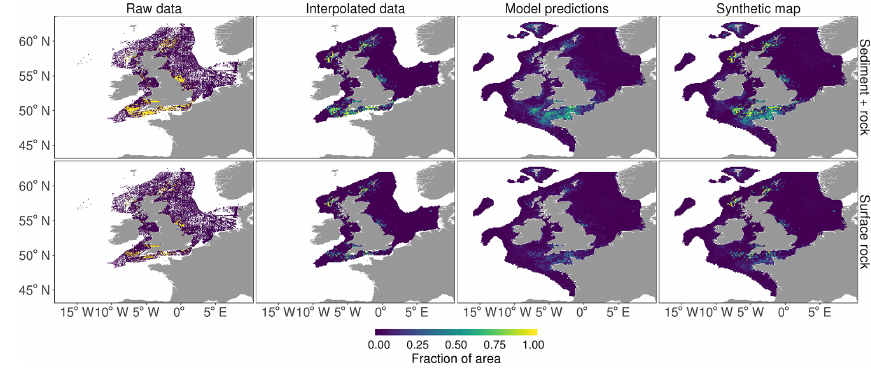
Figure 9. Proportion of area in each rock classification. Areas were classified by whether there was rock at the surface or a surface sediment layer plus rock in the top 50cm. Historical survey logs and borehole records were first interpolated to provide a map of rock cover where we have sufficient data. Random forests were used to predict rock cover elsewhere using wave and tidal velocities, bathymetry, measures of bathymetry variation and distance from the coast as